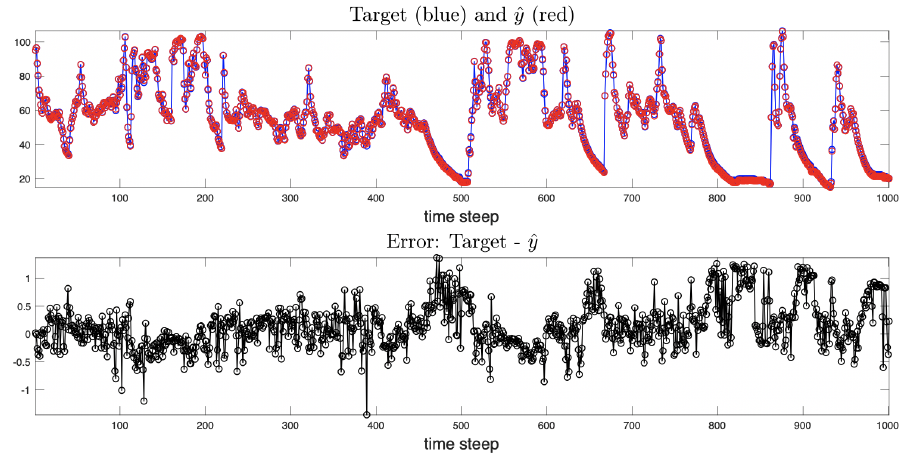
Figure 4. ( Top ) temporal sequence of the target (blue line) and the prediction made by the model (red line) are presented. ( Bottom ) the prediction error is shown.